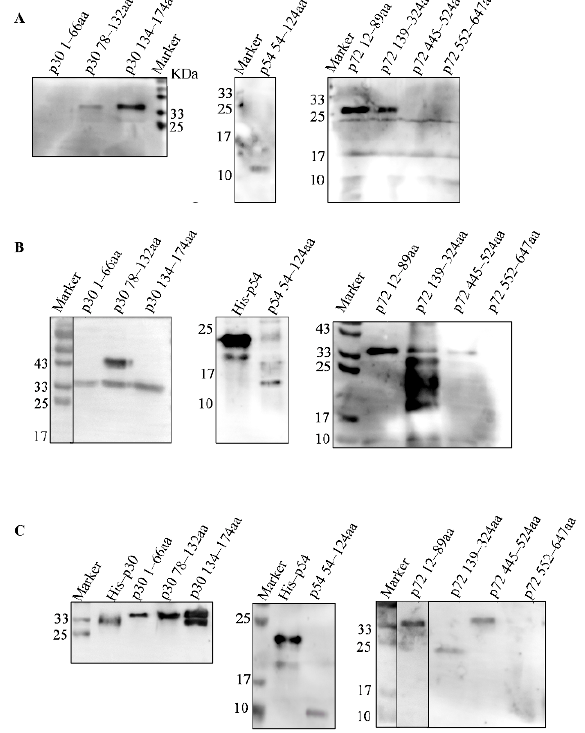
Figure 5. Screening the antigenic dominants of p30, p54 and p72 proteins. Screening the dominant antigenic domains. All the truncated proteins were separated by SDS–PAGE and transferred to PVDF membrane. The target proteins were probed with ASFV positive pig serum ( A ), mouse anti–p30, –p54 and –p72 polyclonal antibody ( B ) and rabbit anti–p30, –p54 and –p72 polyclonal antibody ( C ).